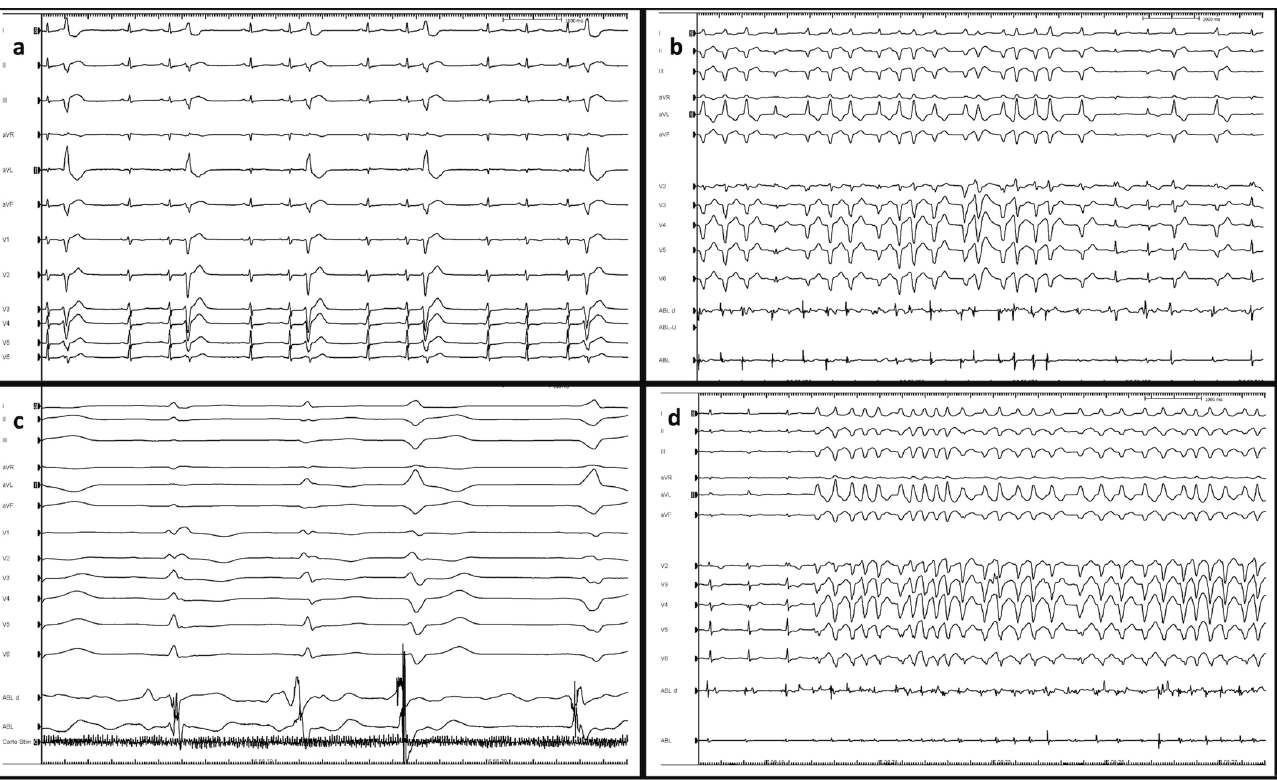
Figure 3. ( a ) Basal Electrogram and PVC; ( b ) Ventricular tachycardia; ( c ) Identification of Purkinje fiber potential during catheter ablation of premature ventricular complex originating from moderator band. Purkinje fiber potential is represented by a sharp, short-lasting, high-frequency potential and prepotential; ( d ) ventricular tachycardia during RF.